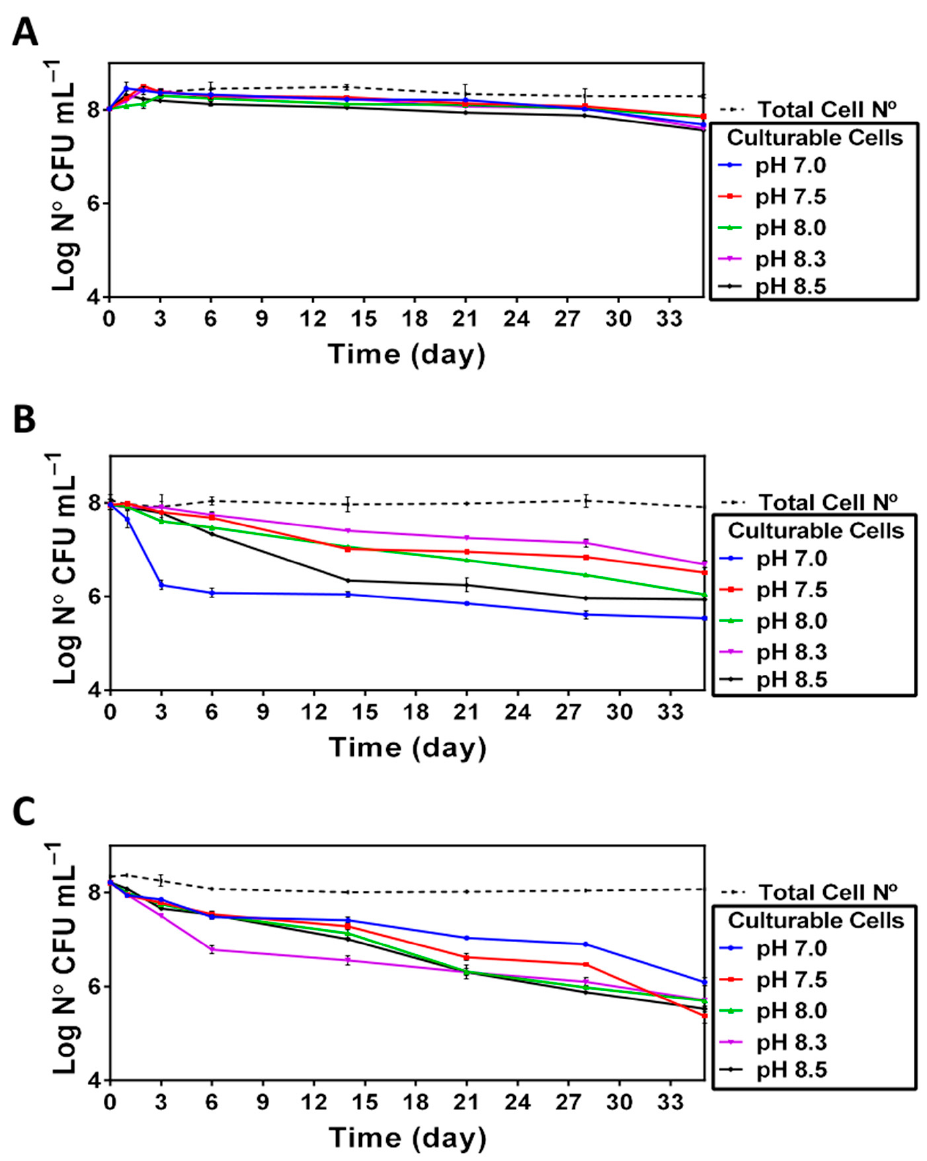
Figure 3. Culturability of V. harveyi (Log CFU mL − 1 ) at 20 °C ( Panel A ), 25 °C ( Panel B ) and 30 °C ( Panel C ). Culturability and total bacterial count were determined as described in Section 2 for cultures incubated at different temperatures (20, 25 and 30 °C) and different pH (7, 7.5, 8, 8.3 and 8.5). The mean values and standard deviation (indicated by vertical bars) were calculated based on the data obtained in 3 independent